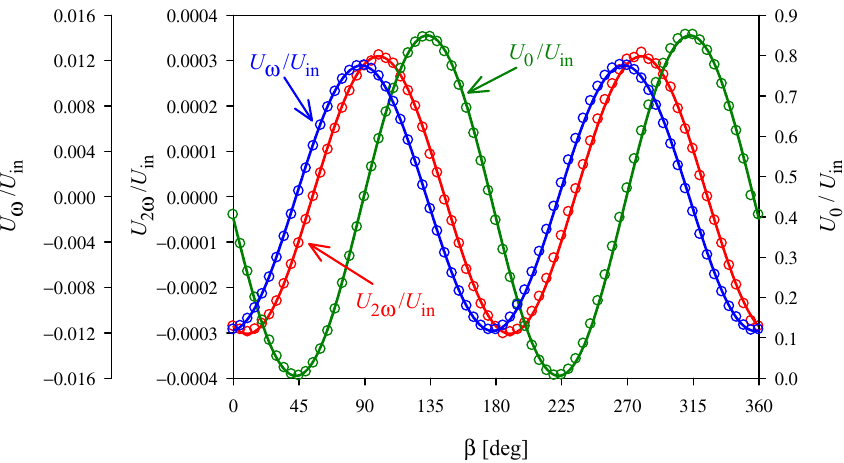
Figure 6. Example of experimental data obtained in the configuration (23) for T = 30°C, α = − 45°, θ = − 45°, and modulating voltage 3060 V RMS. The solid lines show interpolations of the type U X / U in = a + b sin(2 β + φ ).